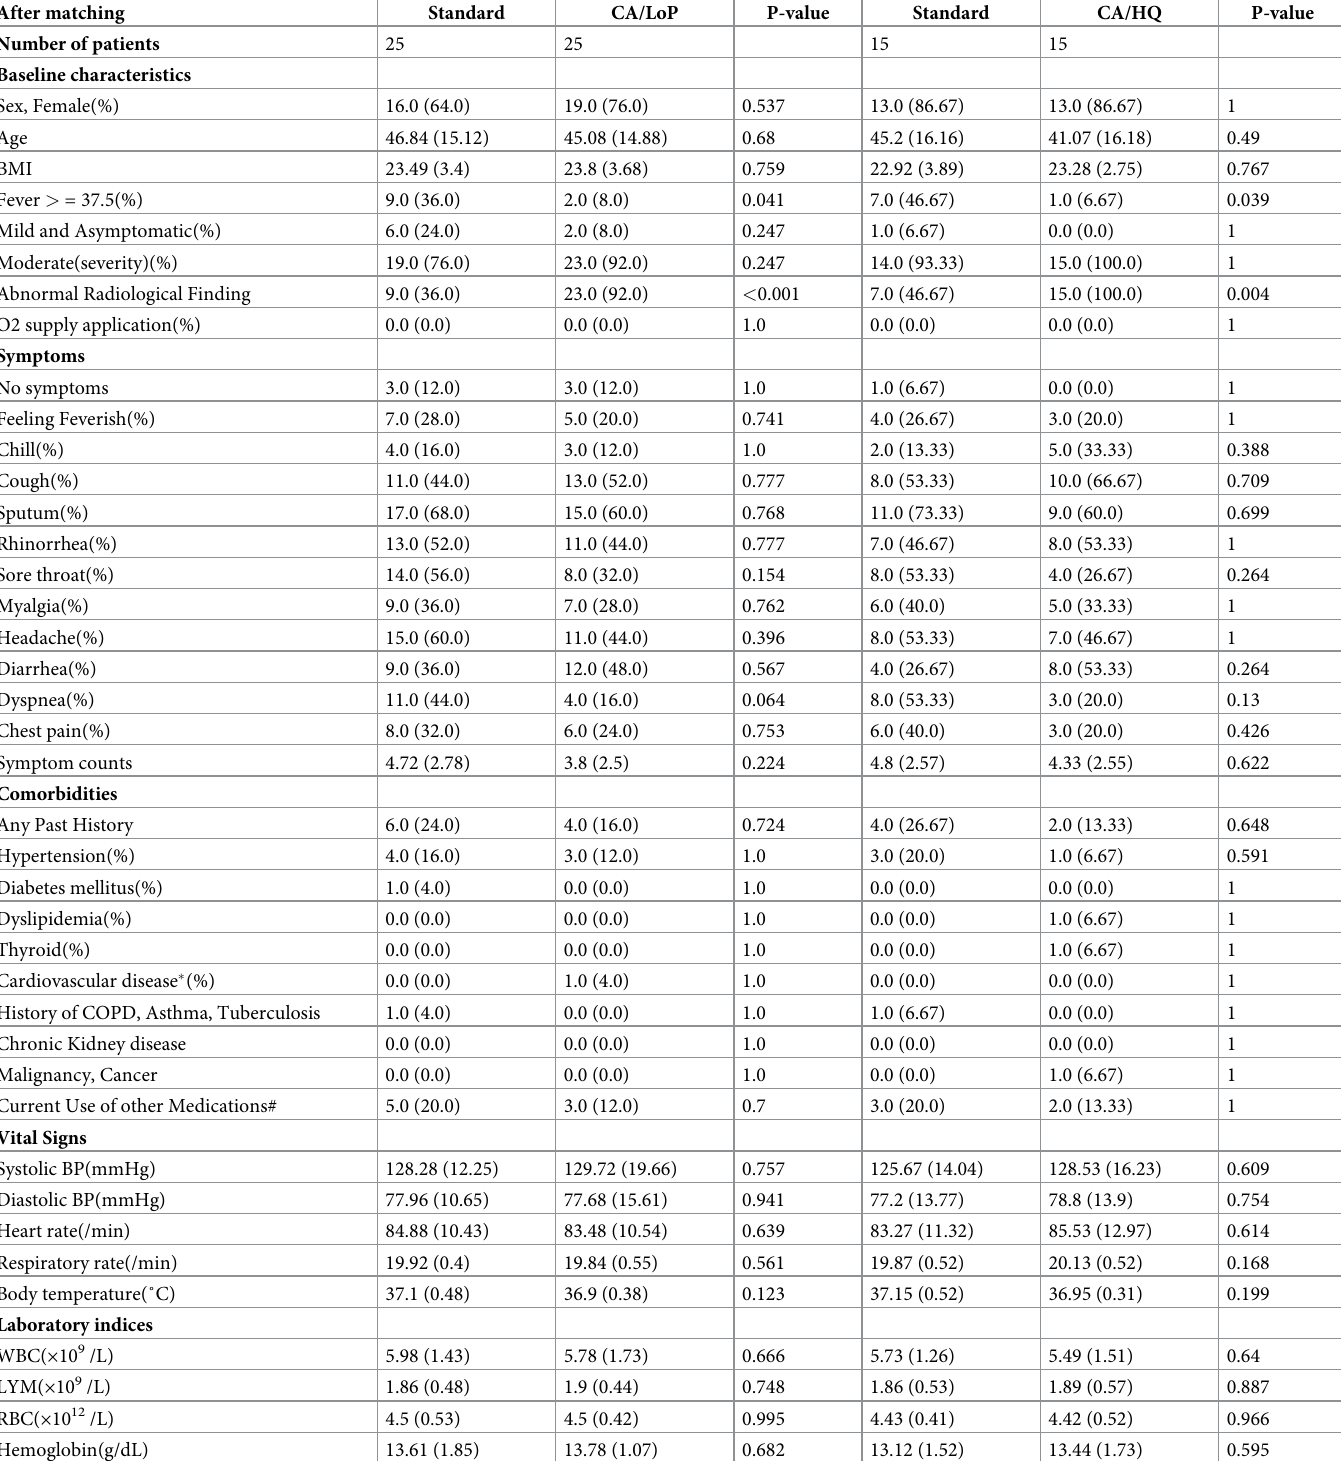
Table 2. Baseline characteristics, symptoms, comorbidities, vital signs, and initial laboratory indices of Standard and CA/LOP group, CA/HQ group after propen- sity score matching. After